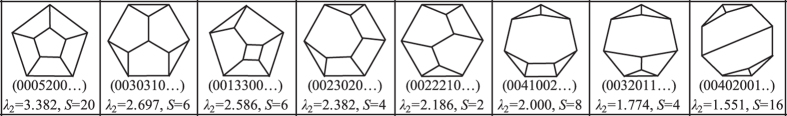
All eight 7-faced grain forms.